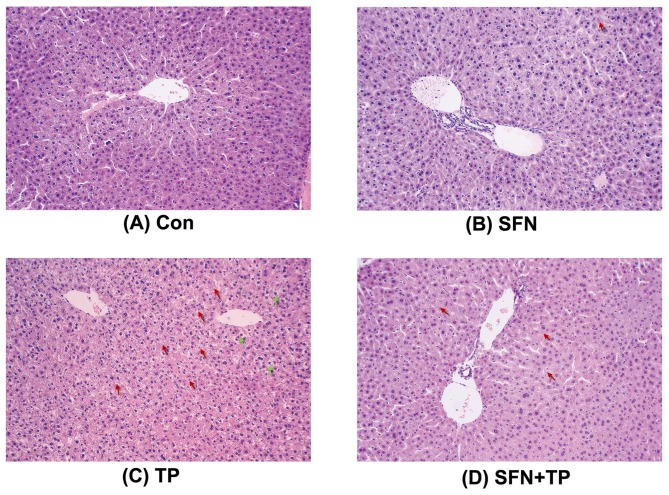
Photomicrographs of hematoxylin and eosin-stained liver sections.Mice were sacrificed 24-µm intervals and then stained with hematoxylin and eosin for light microscopic analysis (×100). The photomicrographs are of livers obtained on (A) Con group, (B) SFN group, (C) TP group, (D) SFN+TP group. Green arrows indicated hepatocellular hydropic degeneration, red arrows indicated necrosis.